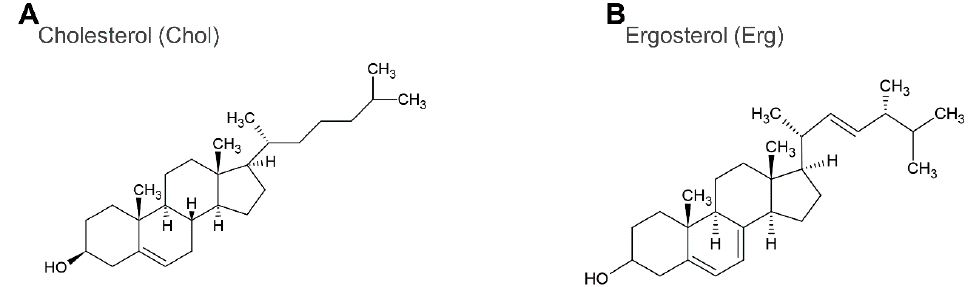
Figure 2. The structures of cholesterol (Chol, A ), and ergosterol (Erg, B ) .